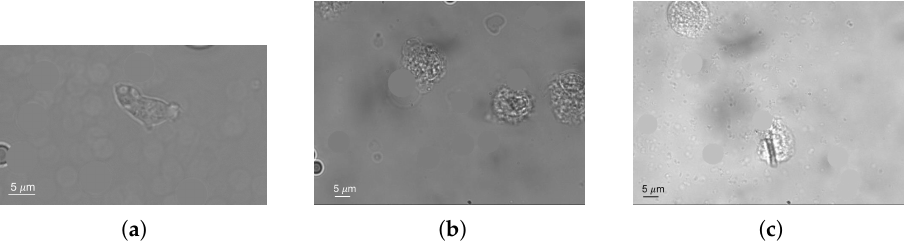
( x , y ) ; ( b ) I sw ( x , y ) ; ( c ) I sm ( x , y ) . jbh jbh jbh